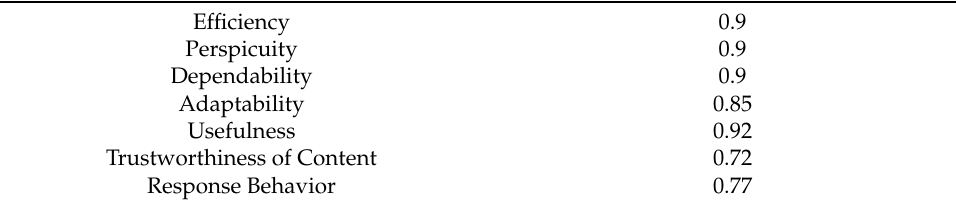
Table 6. Cronbach per scale.